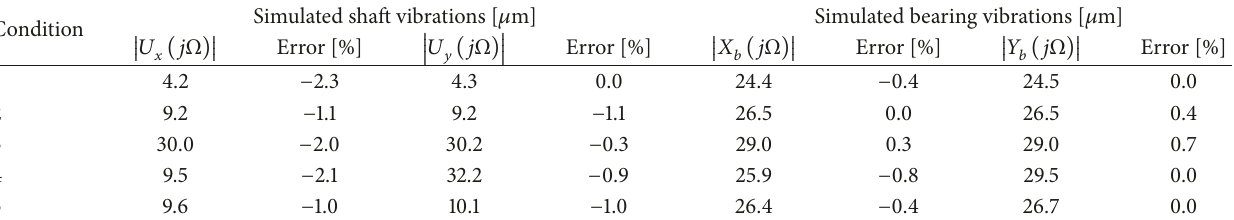
Table 6: Simulated shaft and bearing vibrations at the upper journal bearing, using the estimated bearing effective stiffnesses, including the errors in comparison to the vibrations shown in Table